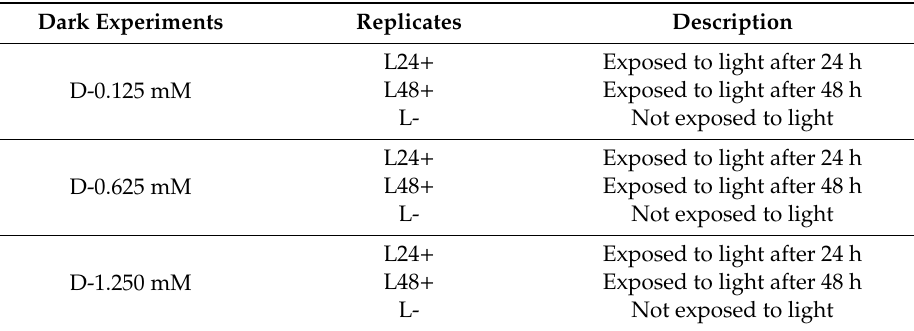
Table 2. The one-factor-at-a-time (OFAT) experiment design at three AgNO 3